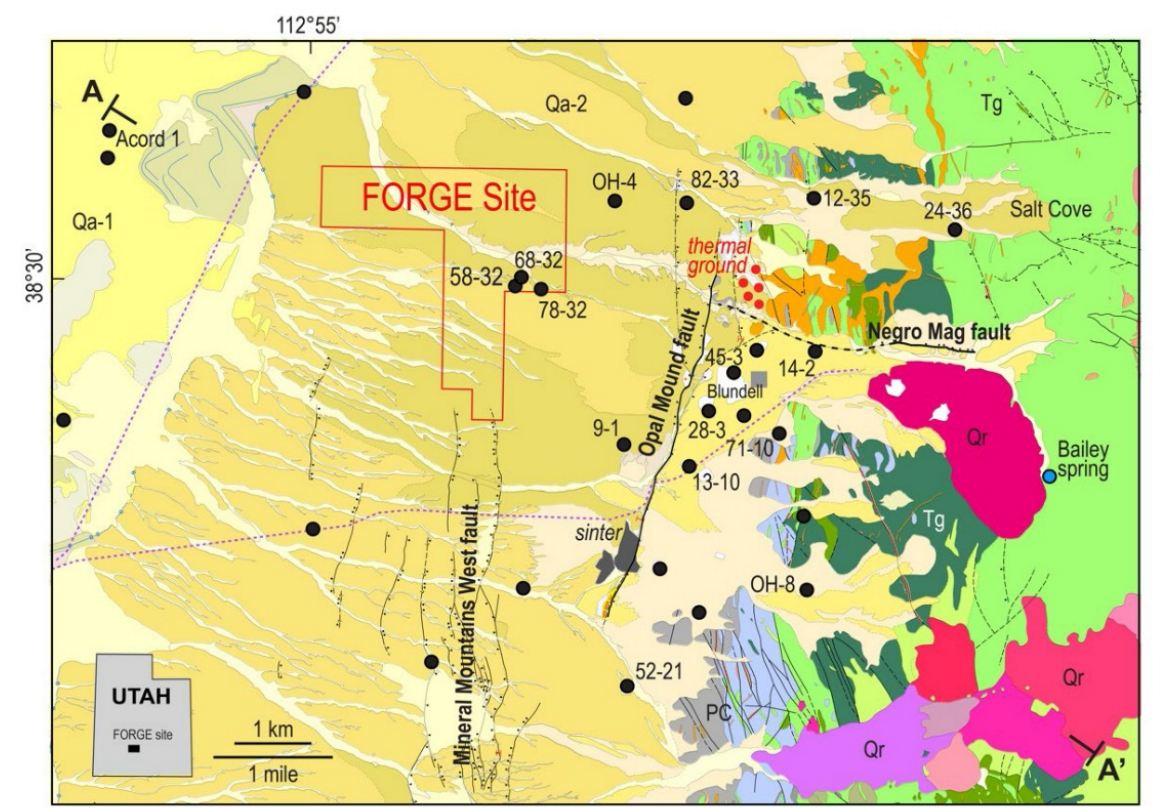
Figure 4. Geological map of the FORGE Utah site [25] based on the compilation from new field observations, well data, and previous work [26,27] Abbreviations: Qa-1 = Lake Bonneville silts and sands; Qa-2 = alluvial fan deposits; Qr = quaternary rhyolite lava and pyroclastic deposits; Tg = tertiary granitoid; PC = Precambrian gneiss; black filled circles = wells.